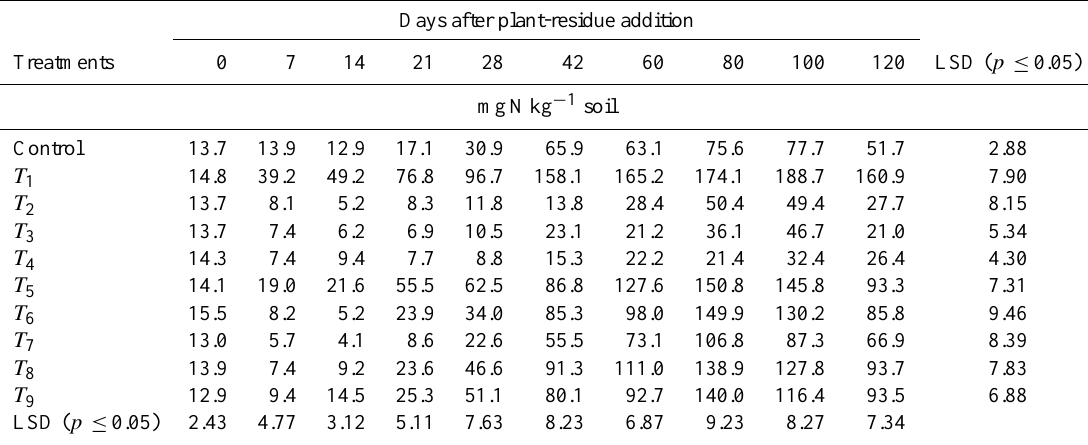
Table 3. Mean changes in the concentration of total mineral N of a soil amended with different plant residues and incubated at 25 ◦ C under controlled laboratory conditions during a 120-day period ( n = 3).